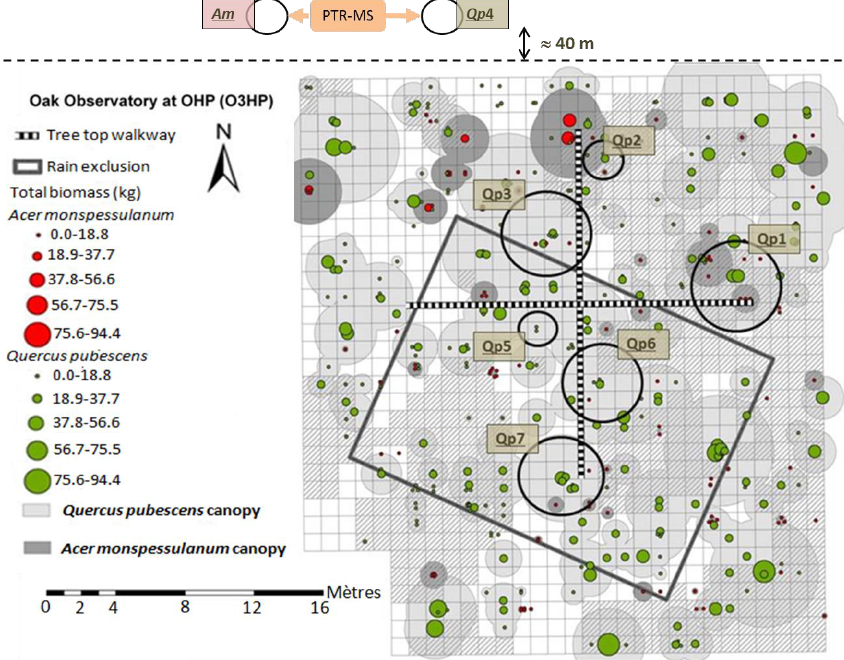
Figure 1. Location of the studied i Q. pubescens ( Qp i) and Acer monspessulanum ( Am ) trees. Branches Qp 4 and Am were located ≈ 40m 756 north of the O 3 HP footbridge and BVOC emissions were measured using an online PTR-MS. All other Qp i branches were sampled from the O 3 HP footbridge using adsorbent cartridges. Black circles in the O 3 HP area represent the assessed crown area of the sampled